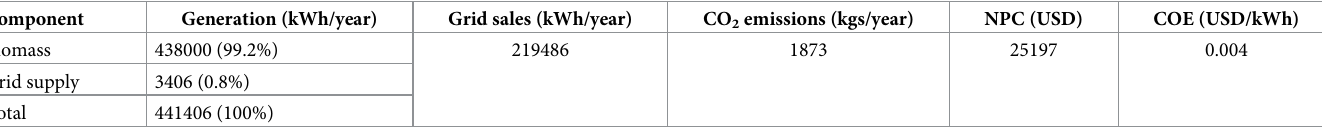
Table 7. Simulation results for